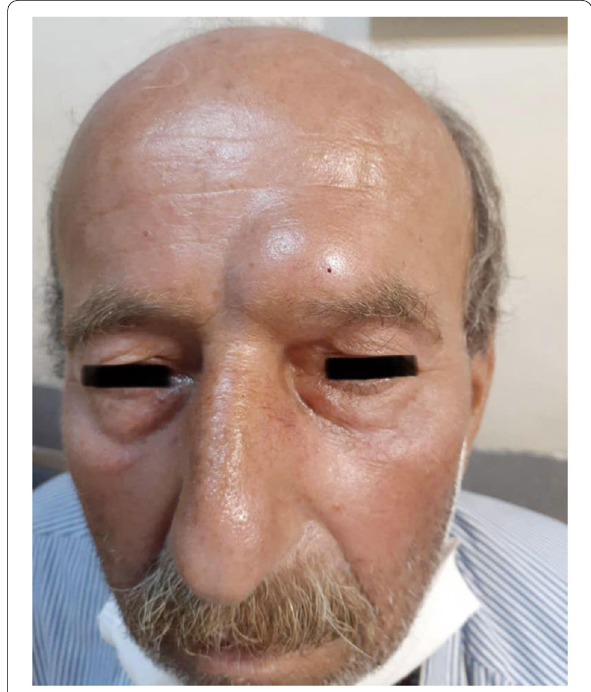
Fig. 1 The patient presenting with a left-sided frontal bossing